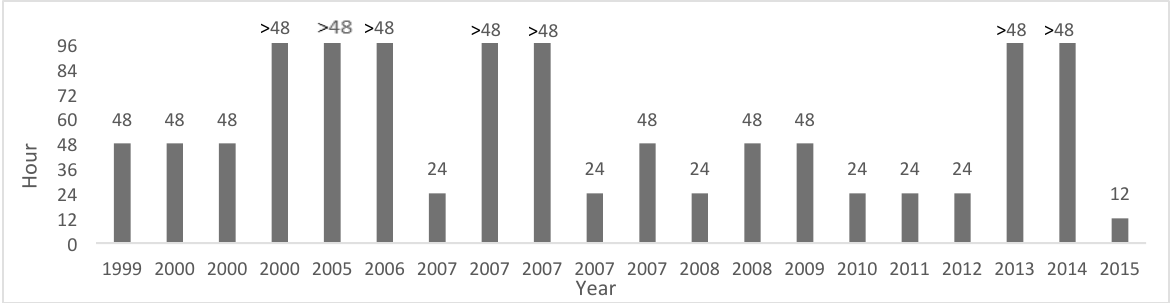
Fig.2. Year Vs exposure dose (Hr.)